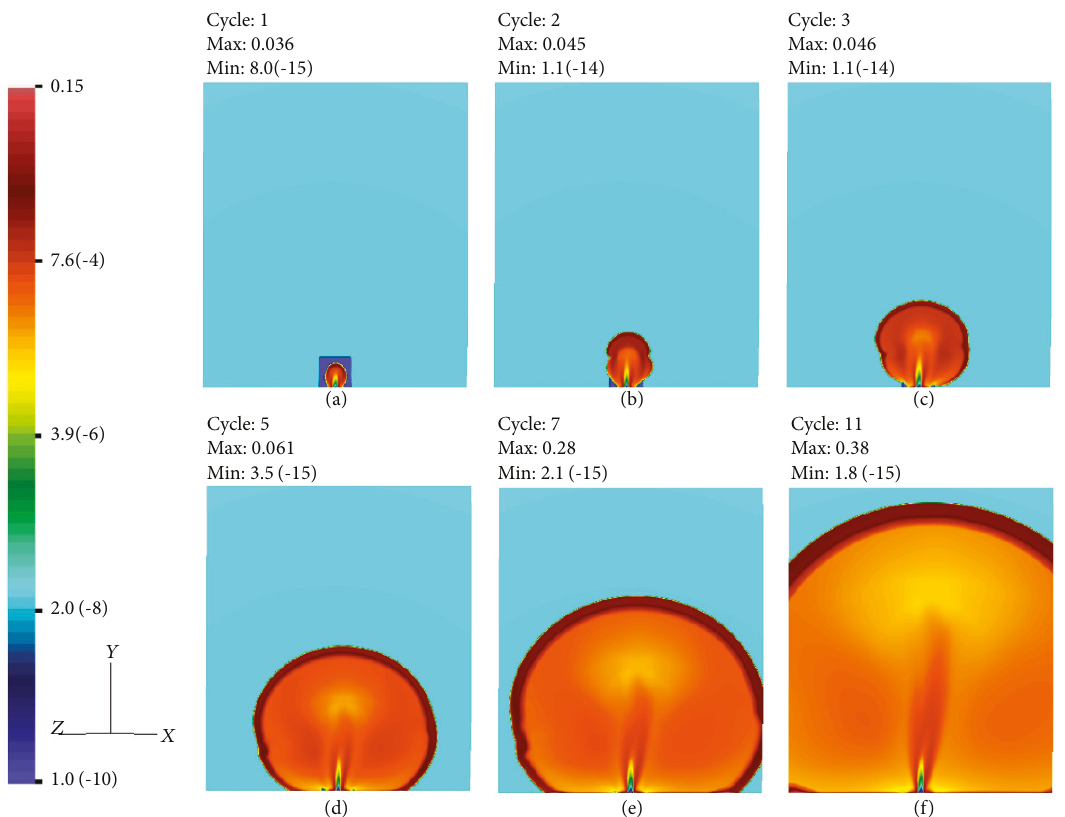
Figure 7: Scenario D: a series of plots for the jet temperature of run4 (run4 parameters in Table 1). This plot shows 2D slices cut along the jet, depicting the temperature on the slice, at a specific time instant. The, faster than previous runs, advance of the jet, through surrounding wind matter, is characterized by an expanding shock front. Said expansion is initially slower, till the jet crosses the simplified accretion disk wind construct. Then, a higher rate of expansion occurs, especially to the sides, as the stellar wind gradient is less pronounced, since we have Δ𝑥 < Δ𝑟 , where 𝑥 is the jet crossing distance and 𝑟 is the distance to the binary companion star.